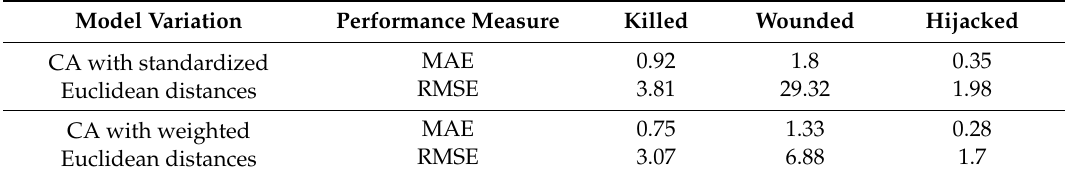
Table 3. Average model performances by category of security incidents.